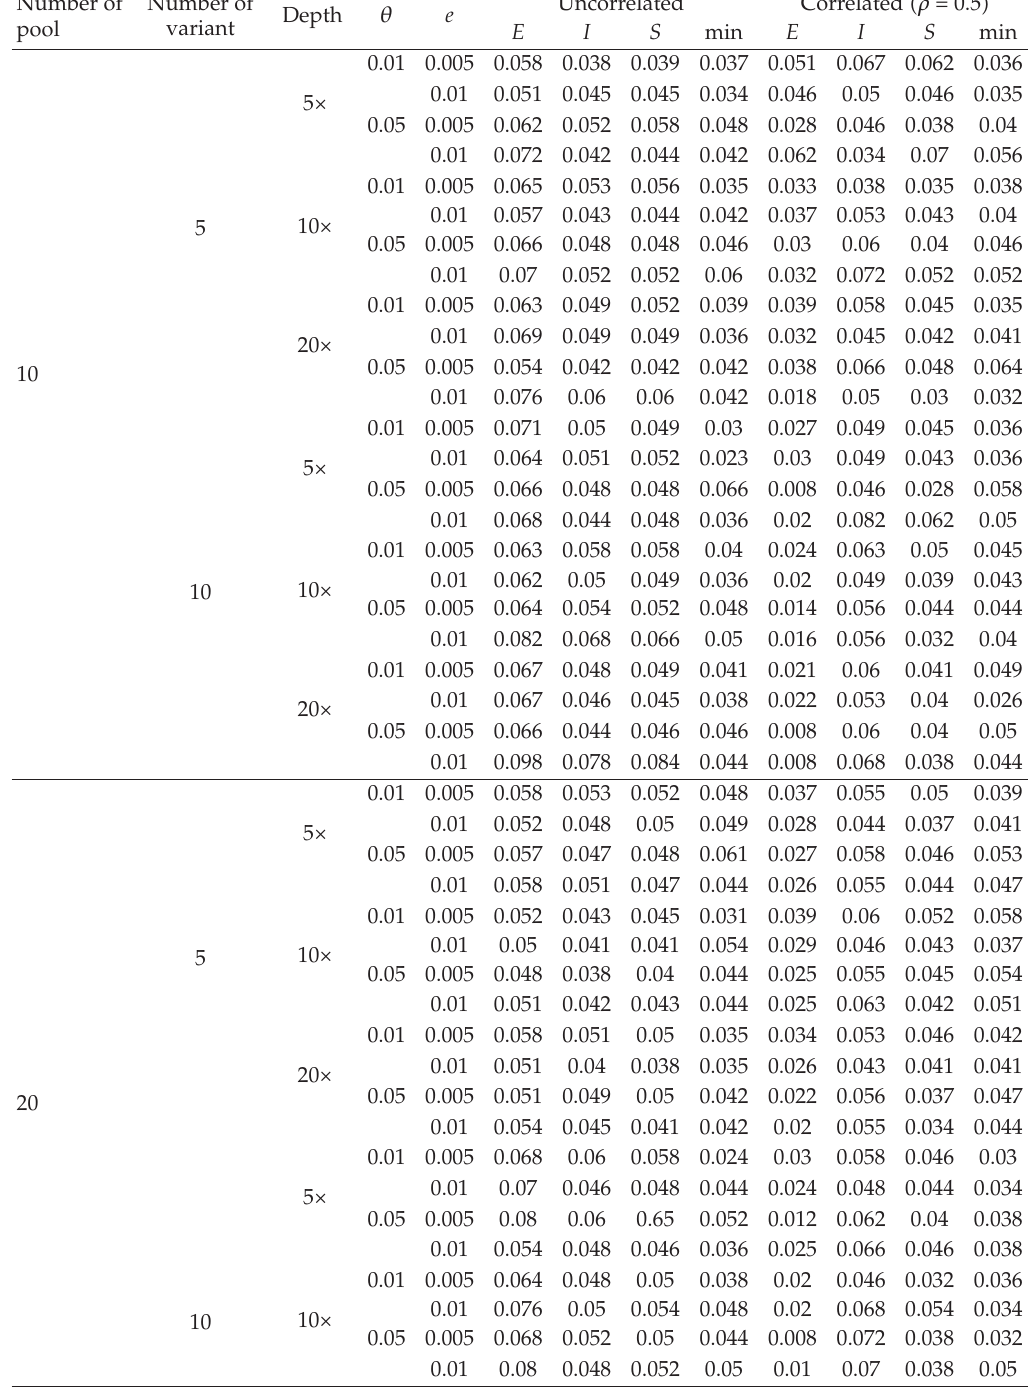
Table 3: Type I error rates at a level of 5% for multivariant tests under various allele frequencies, error rates, depths of coverage, and numbers of variants for testing association. Sample size was set at 500 cases and 500 controls. Simulations were based on the unbalanced design with 10 and 20